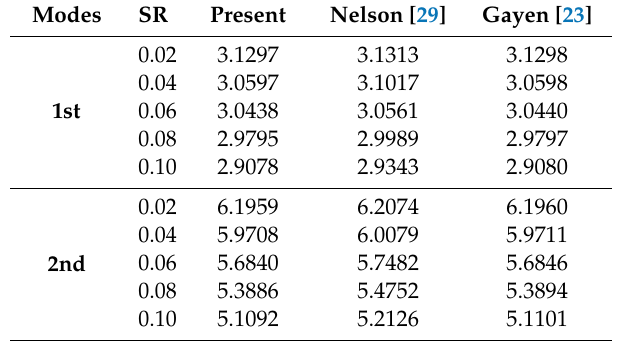
Table 2. Natural frequencies of a homogeneous nonrotating simply supported